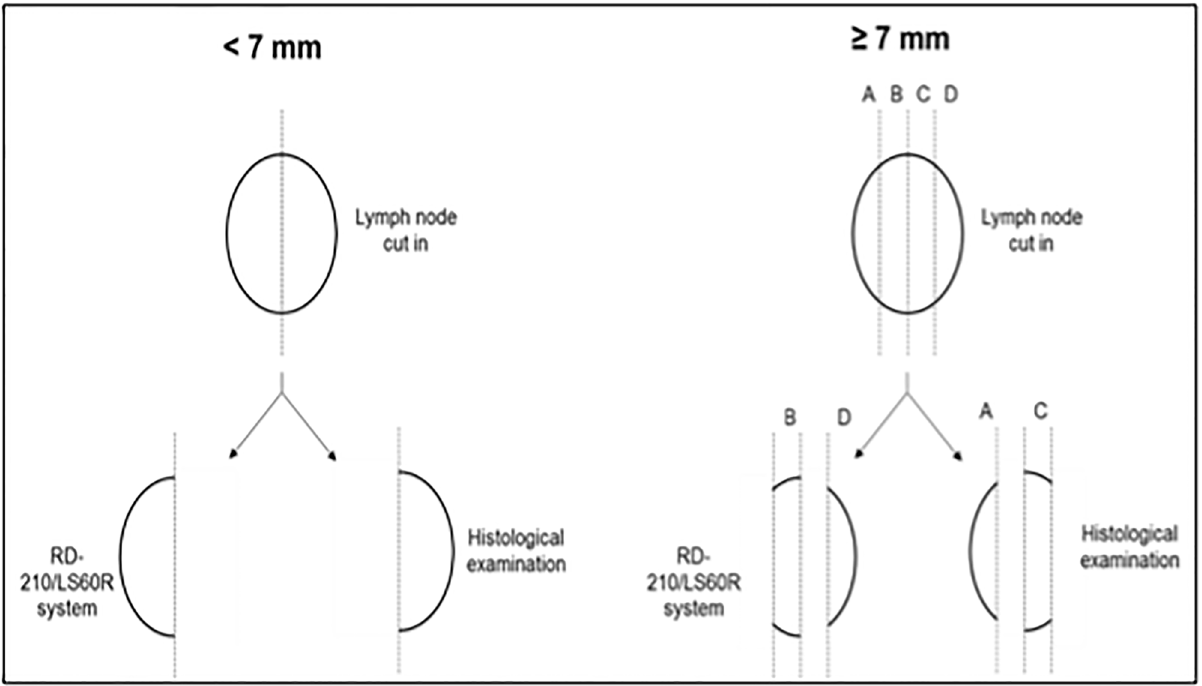
Fig 1. Schematic representation of lymph node